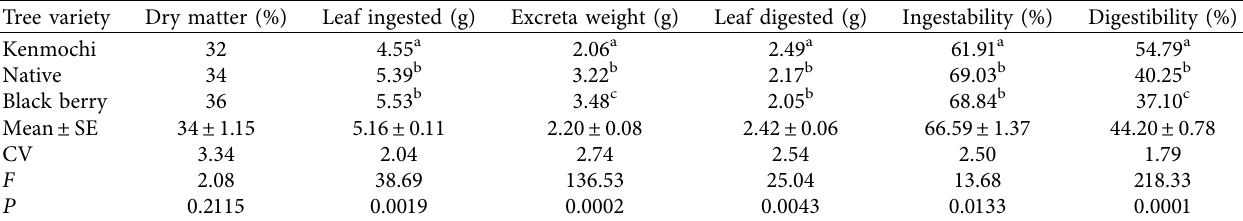
Table 2: Mean of larvae and cocoon traits of a silkworm hybrid fed with three varieties of mulberry leaves. Tree variety Native